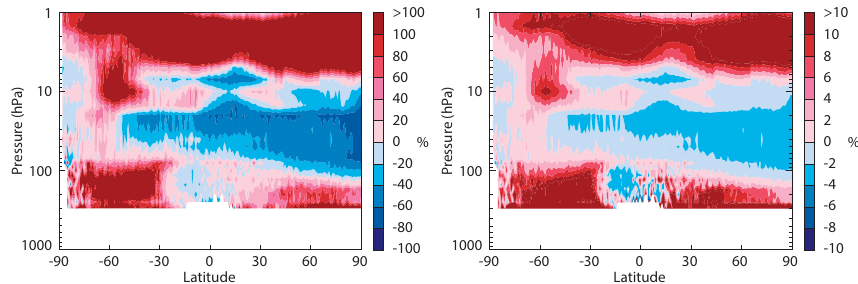
Figure 6. As in Fig. 5 but for the CCI MIPAS LPO 3 data.